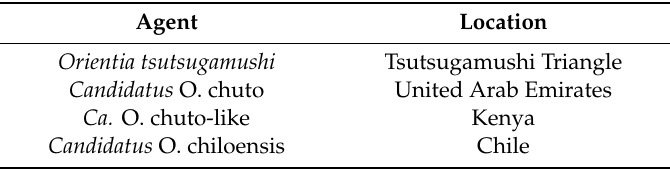
Figure 3. Phylogenetic Tree. The evolutionary relationships of Orientia species detected outside of the Tsutsugamushi Triangle were compared with Orientia tsutsugamushi strains, Rickettsia species and other bacteria. The tree was constructed with the 560 bp rrs gene fragments using the Maximum Likelihood method and the Tamura–Nei model in MEGAX. The values of the bootstrap test (1000 replicates) were shown next to the branches. Table 5. Current Known and Proposed Agents of Scrub